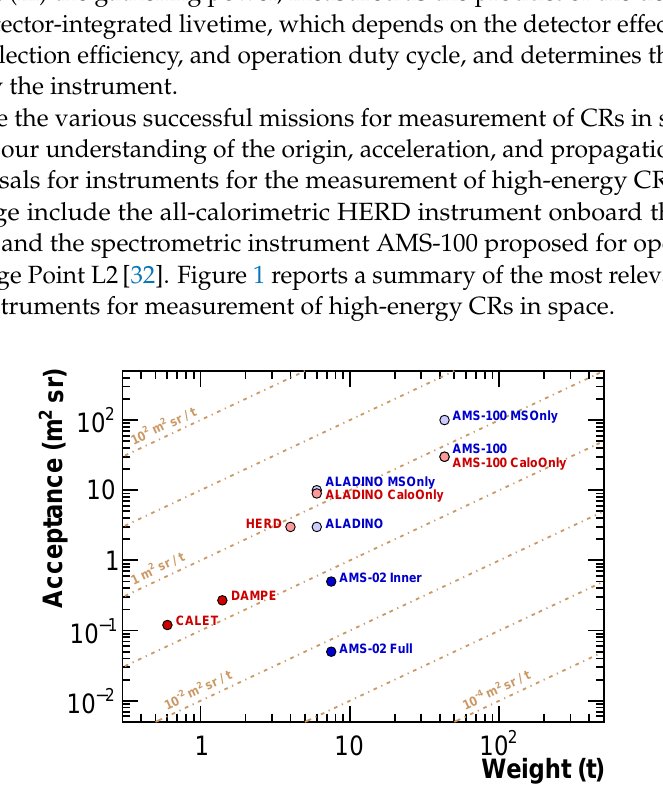
Figure 1. Acceptance and weight for the most relevant operating (full dots) and proposed (shaded dots) instruments for measurement of high-energy CRs in space. Blue and red dots represent, respectively, spectrometric and calorimetric instruments. The values reported in the picture are from[33] (CALET), [34,35] (DAMPE), [36–39] (AMS-02), [40] (HERD), [32] (AMS-100). The values of acceptance may depend on the analysis to which they are referred, and shall be considered as a benchmark value only. For AMS-02, the values are reported separately for particles in the acceptance of the AMS-02 inner tracker (AMS-02 Inner) or of the AMS-02 full tracker (AMS-02 Full). For ALADInO and AMS-100, the values are reported separately for particles in the acceptance of the magnetic spectrometer and calorimeter, of the magnetic spectrometer only (MSOnly), and of the calorimeter only (CaloOnly). NB: this picture does not provide the full set of information to determine the final performances of each detector, because other factors (such as the spectrometer MDR or the calorimeter depth and geometry) should be taken into account. For example, for the high-energy e ± measurement, ALADInO is to be compared with AMS-02 Full, which is the AMS-02 configuration with the largest